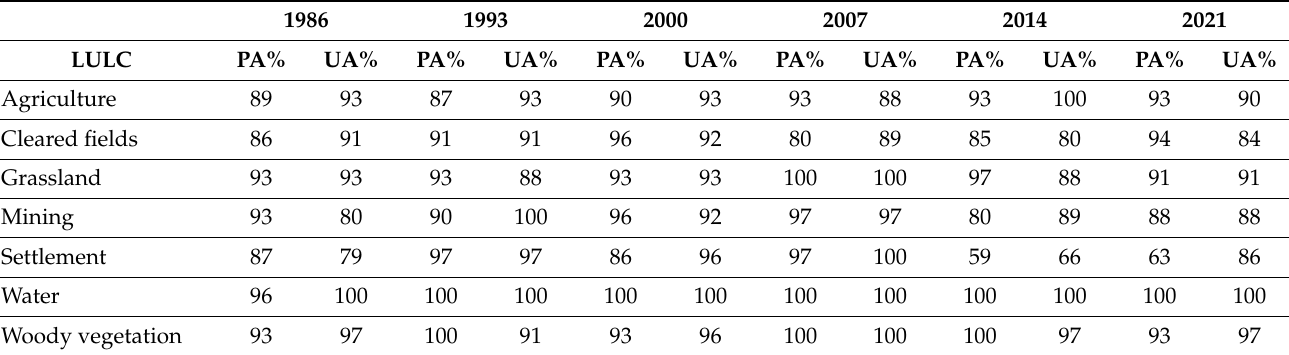
Table 6. The producer accuracies (PAs) and user accuracies (UAs) of the LULC classifications for the Vaal